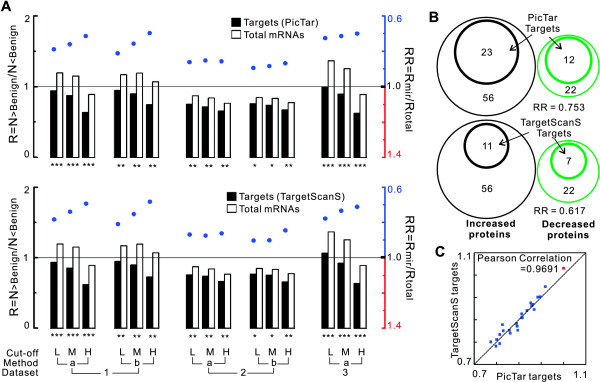
Comparison of transcript levels of miRNA targets between in prostate cancer and in benign tissues. (A) The transcript levels of miRNA targets in prostate tumours were compared with those of total mRNAs using Rmir, Rtotal and RR values (see methods). The R values of all miRNA targets (Rmir) and total altered mRNAs (Rtotal) are represented as black and white bars, respectively. Also plotted are the RR (Rmir/Rtotal) values (colored dots, right axis). The RR value is a surrogate for an increased or decreased abundance of miRNA targets relative to total mRNAs. Blue color denotes RR < 1 and red denotes RR > 1. Three gene expression microarray datasets (Dataset 1, 2 and 3) were used for this comparison. Three different cut-off values (L: Low; M: Medium; and H: High) and two methods a and b (for dataset 1 and 2) were chosen to rule out the bias of single method. Asterisk represents the statistical significance of each comparison (resampling statistical test, see methods). One asterisk means P < 0.05; two asterisks, P < 0.01; three asterisks, P < 0.0002. The complete data are reported [see Additional file 1]. (B) Analysis of the protein levels of miRNA targets using a small proteomic dataset. Black and green cycles represent the numbers of increased and decreased proteins in prostate tumours relative to benign prostate tissues, respectively. Small cycles represent the number of miRNA targets mapped into these two protein groups. Areas of the cycles are scaled to the proteins number. (C) Correlation between the RR values obtained using two different miRNA target predictions.